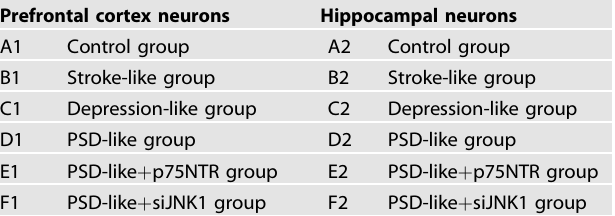
Table 1. Grouping of experimental cells and outline of the